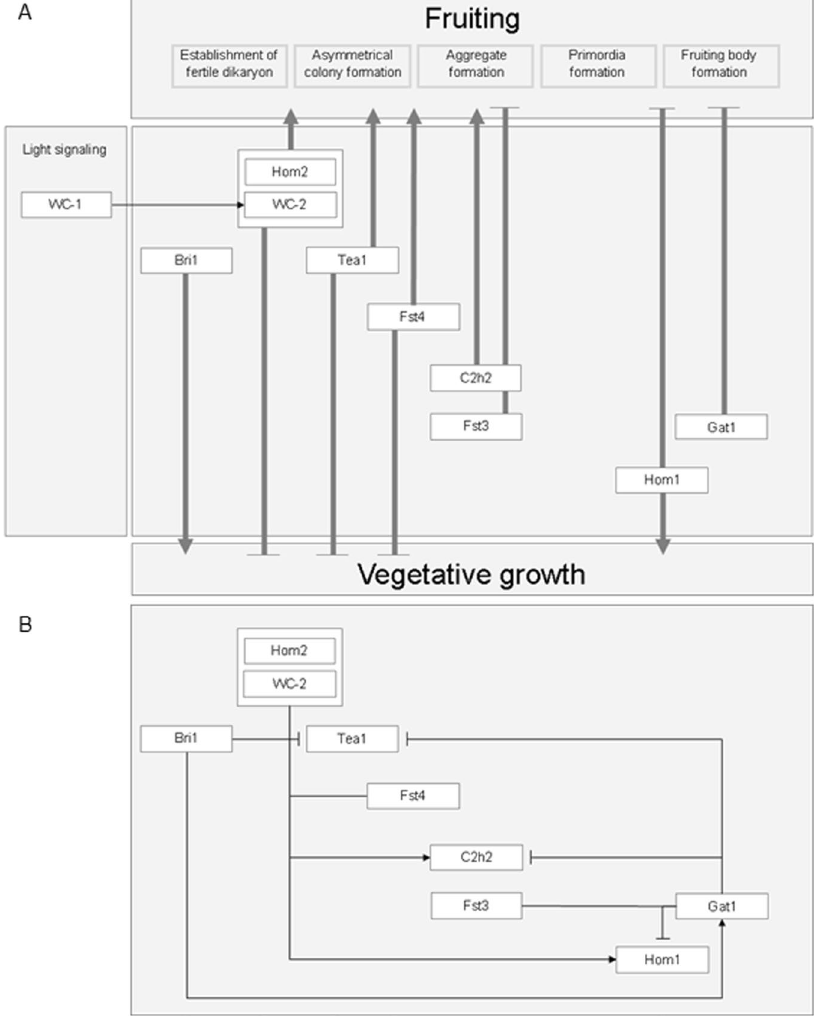
Figure 6. Model of regulation of vegetative growth and fruiting body formation in S. commune . Transcription factor genes control both vegetative growth and fruiting body development ( A ) and influence each other's expression levels ( B